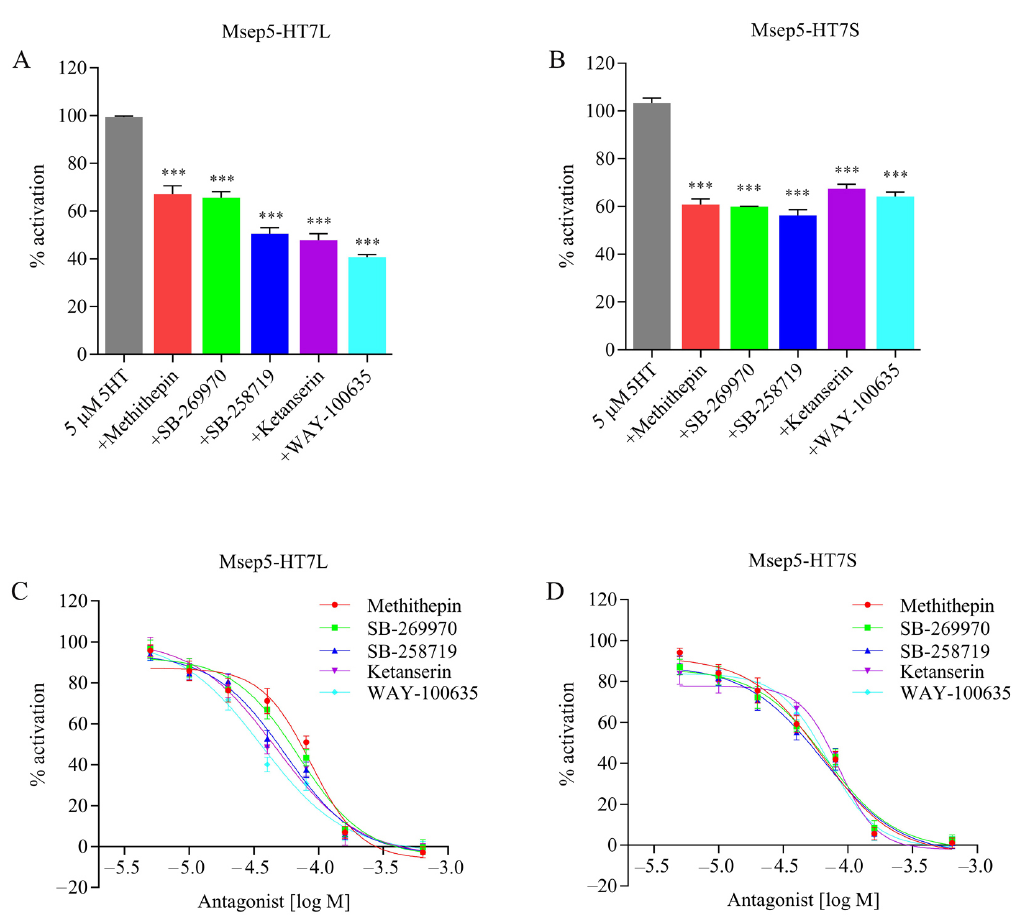
Figure 4. Effects of various potential 5-HT receptor antagonists on HEK293 cells expressing Msep5- HT7L or Msep5-HT7S receptors. For ( A , B ), effects of 40 µ M putative antagonists, shown as percentage of activation, were achieved with 5 µ M of 5-HT (indicated as 100%). Dose-dependent cAMP response to different concentrations of antagonists on HEK293 cells expressing Msep5-HT7L and Msep5-HT7S is shown ( C , D ). Asterisks indicate values significantly different from the control value using one-way ANOVA followed by Dunnett’s multiple comparison test (*** p < 0.001). cAMP levels of cells treated with 5 µ M of 5-HT were defined as 100%; cells treated with only DPBS buffer solution were defined as basal level of 0%. Data are presented as means ± SD from three independent